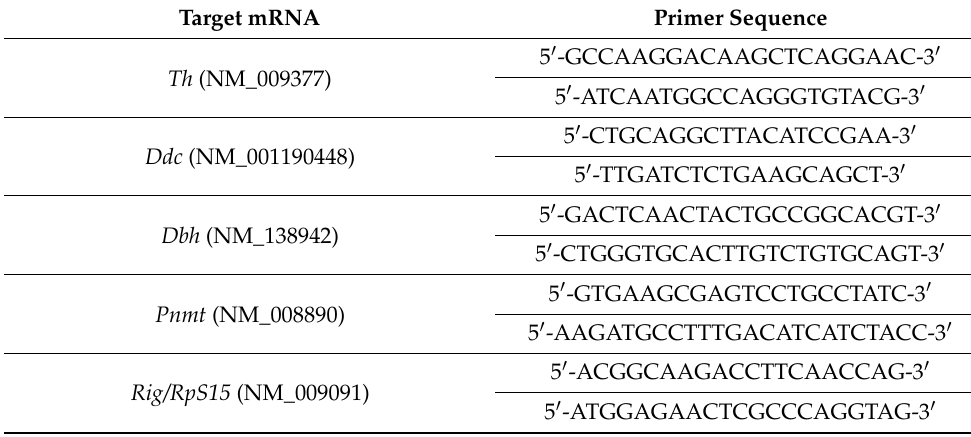
Table 1. PCR primers (mouse) for the real-time RT-PCR.